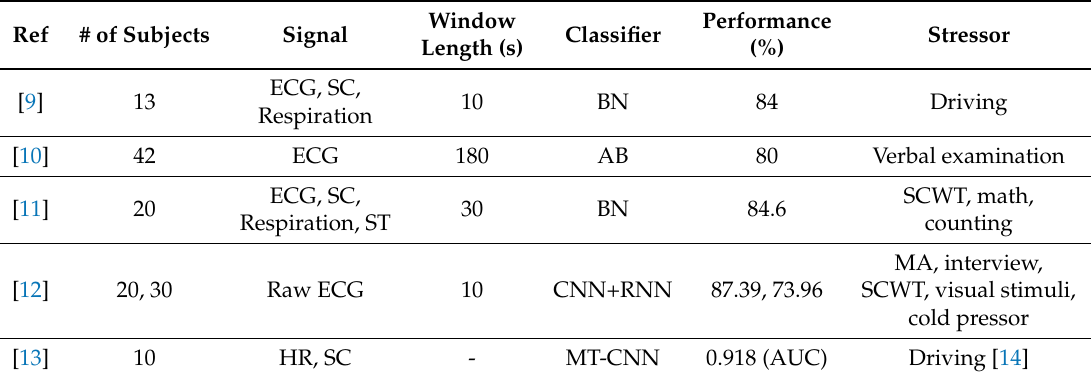
Table 1. Previous studies on stress detection. ECG, Electrocardiogram; SC, Skin Conductance; ST, Skin Temperature; HR, Heart Rate; BN, Bayesian Network; AB, Adaptive Boosting; CNN, Convolutional Neural Network; RNN, Recurrent Neural Network; MT-CNN, Multitask CNN; AUC, Area Under the Curve; SCWT, Stroop Color Word Test; MA, Mental